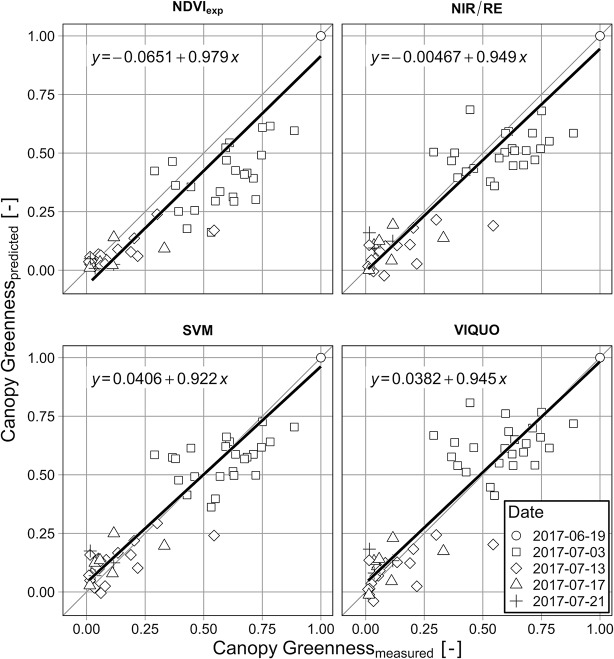
Evaluation of selected GAI-models during the senescence. Data from June 19 is excluded from the calculation of the RMSE because of the self-explanatory perfect fit.